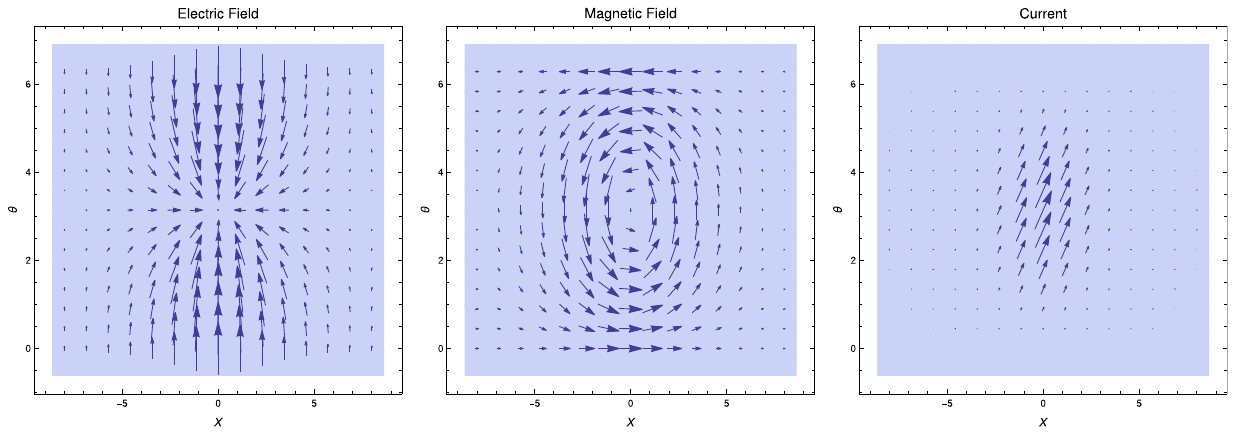
Fig. 4 From left to right, the vector density plots of the Electric field E , the magnetic field B and of the current J